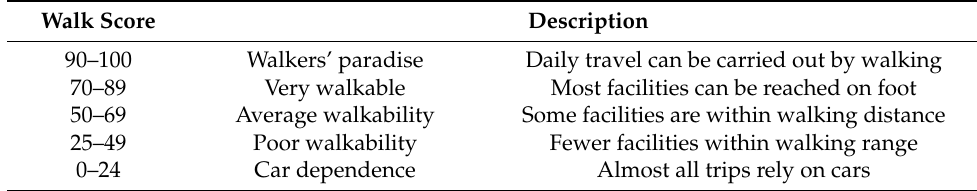
Table 5. Walk score evaluation grade.